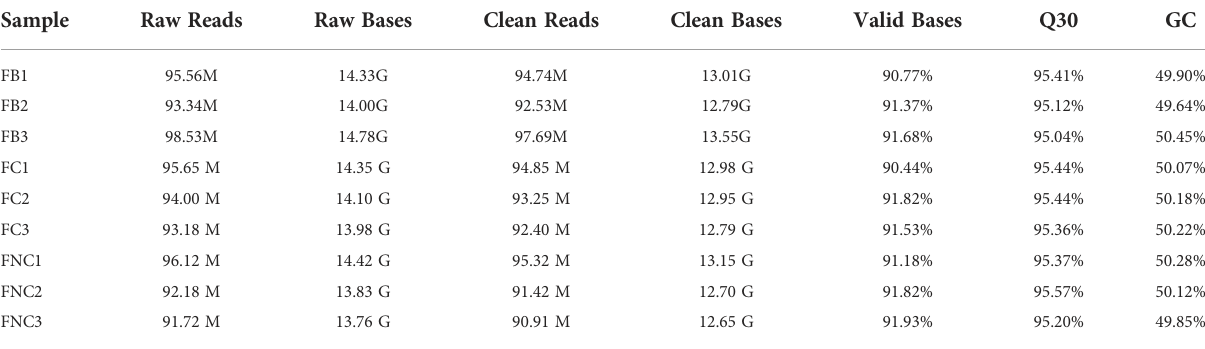
TABLE 2 Quality of the sequencing data.